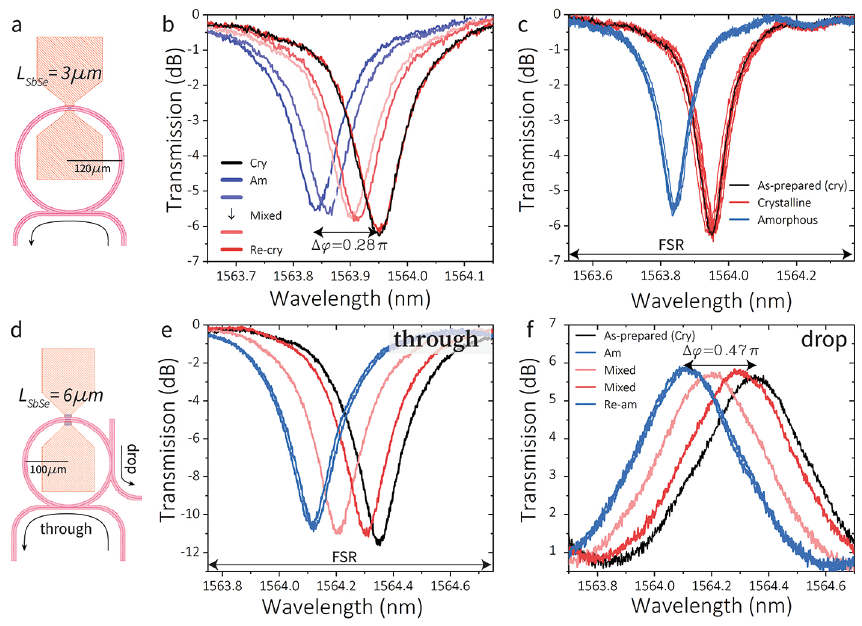
Fig. 3 Reversible and multi-level switching of Sb 2 Se 3 phase shifters in micro-ring resonators. a Layout of a 120 μm- radius, 200 nm-gap micro-ring resonator with a 3 μm-long Sb 2 Se 3 cell. This device is used to experimentally dem- onstrate b one full reversible cycle featuring some of the partial crystallization states and a total of 0.28π shift, in excellent agreement with the expected 0.09 π/µm, and c ten full cycles with excellent reproducibility. d Same ring resonator as in a featuring a drop port identical to the main coupling port. e Demonstration of phase shift of reso- nance dip modulation in the through port with up to 10 dB in ER modulation. f Drop port peaks for the same exact measurements shown in e with a total phase shift of 0.47π. 3.2 V and 100 µs - 1ms pulses were used to partially crystallize and a single 21 V [10.8 V] and 400 ns pulse to fully